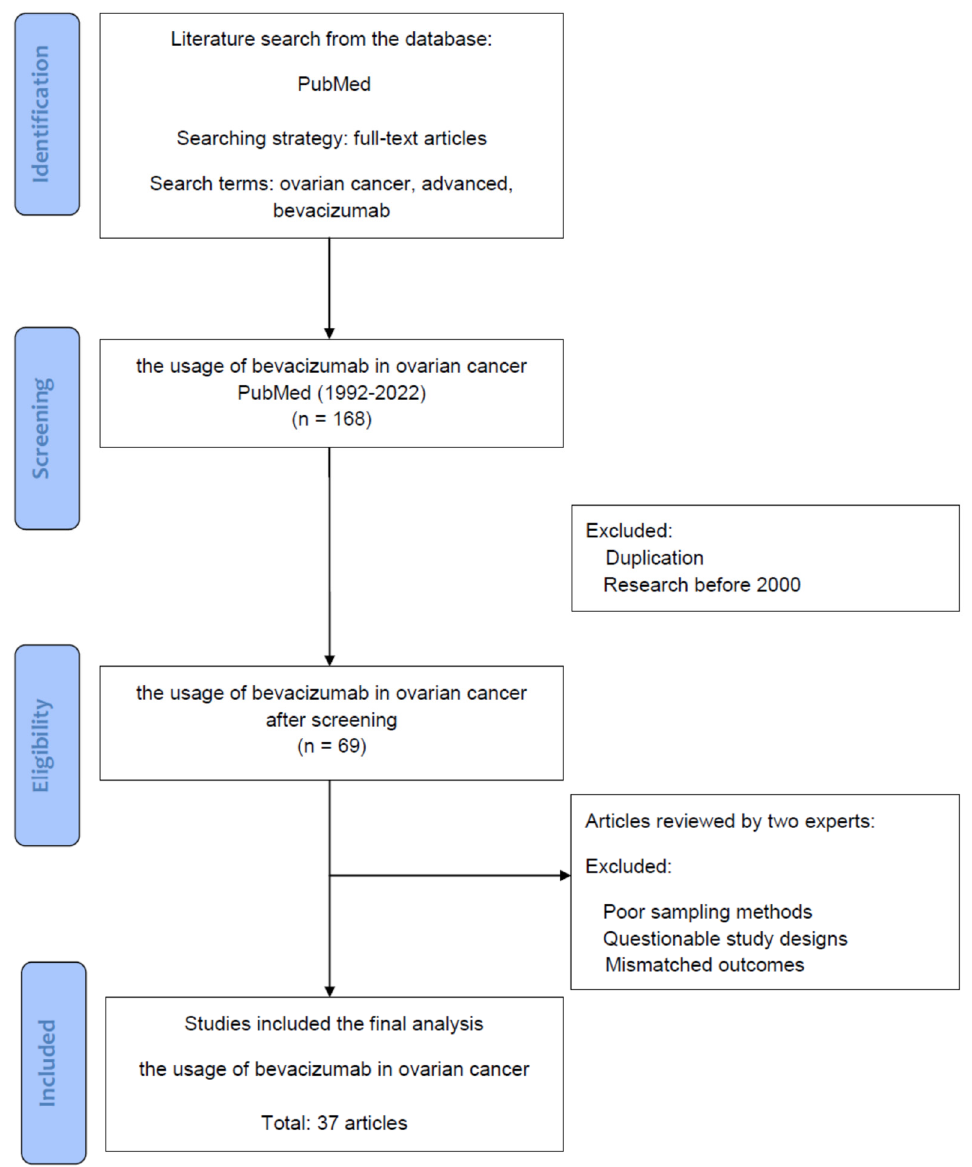
Figure 1. The flowchart of study selection (identification from the database, screening of the studies, selection of potential articles, and final inclusion) to identify eligible articles.